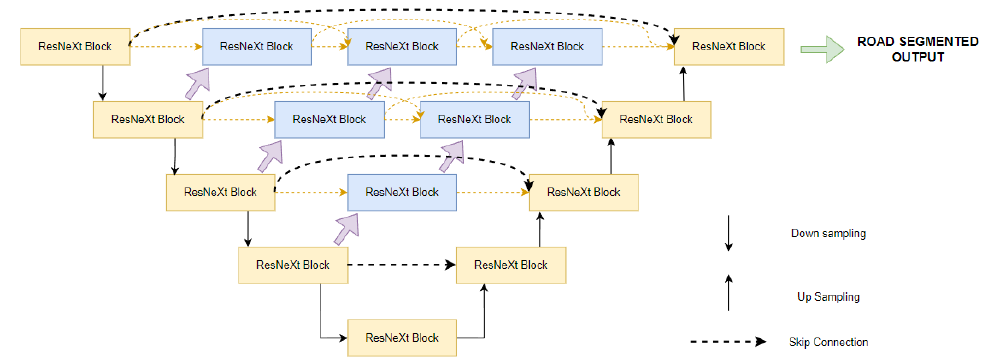
Figure 1. The U-net++ with ResNeXt blocks consist of an encoder and decoder with nested dense convolutional skip connections. The main idea behind U-net++ is to bridge the semantic gap between the feature maps of the encoder and decoder prior to fusion. Here, dark-black lines indicate original U-net, and orange and blue lines indicate U-net++ components introduced by Zhou et al.